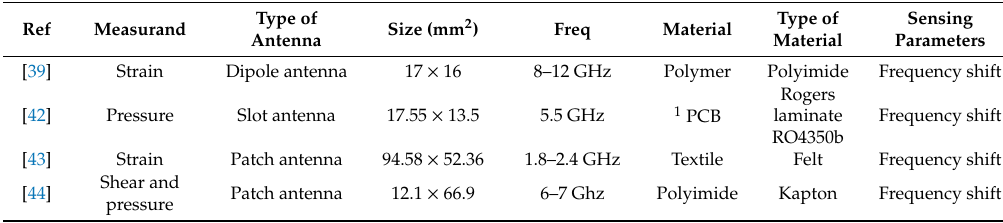
Figure 4. Antenna mechanical sensors for: ( a ) shear detection and ( b ) pressure detection, reproduced with permission from [45]. Table 2. List of antenna mechanical sensors.